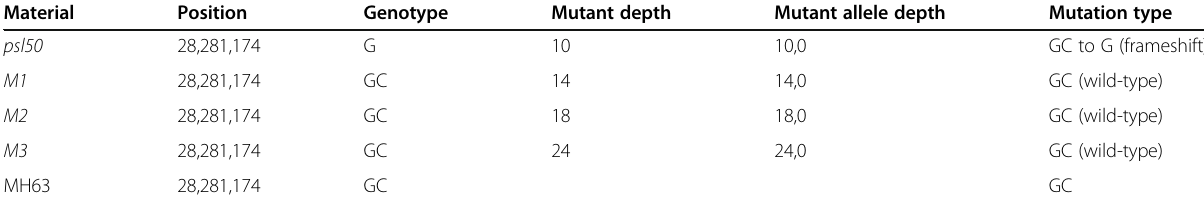
Table 1 Nucleotide comparison of target mutation site between psl50 and the other three mutants Material Position Genotype Mutant depth Mutant allele depth